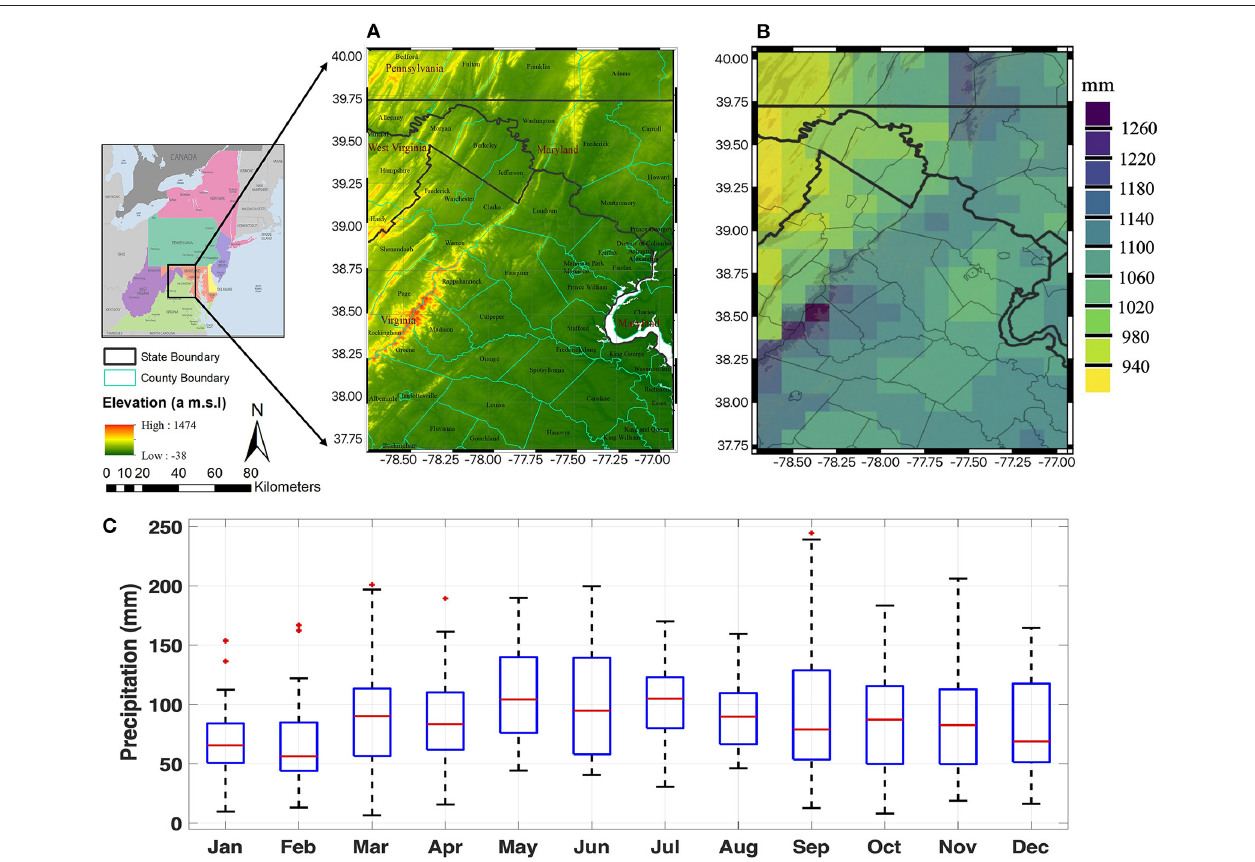
FIGURE 1 | (A) Left: Mid-Atlantic region (www.worldatlas.com/geography/mid-atlantic) with the study area outlined by a black box. Right: regional topography in terms of elevation above mean sea level; (B) NLDAS annual mean precipitation from 1980 to 2018; and (C) boxplots of 39-year monthly precipitation distribution (1980–2018). In each box, the red line indicates the median, the box bottom and top edges indicate the 25 th and 75 th percentiles, respectively. The whiskers extend to the most extreme data points not considered outliers, and outliers are shown with plus marker symbols.